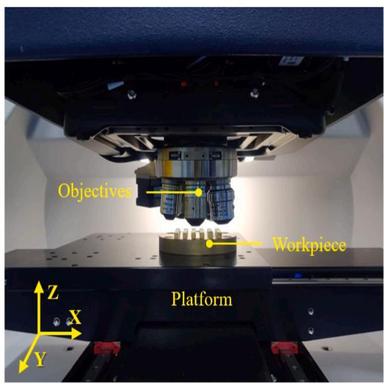
Surface measurements.